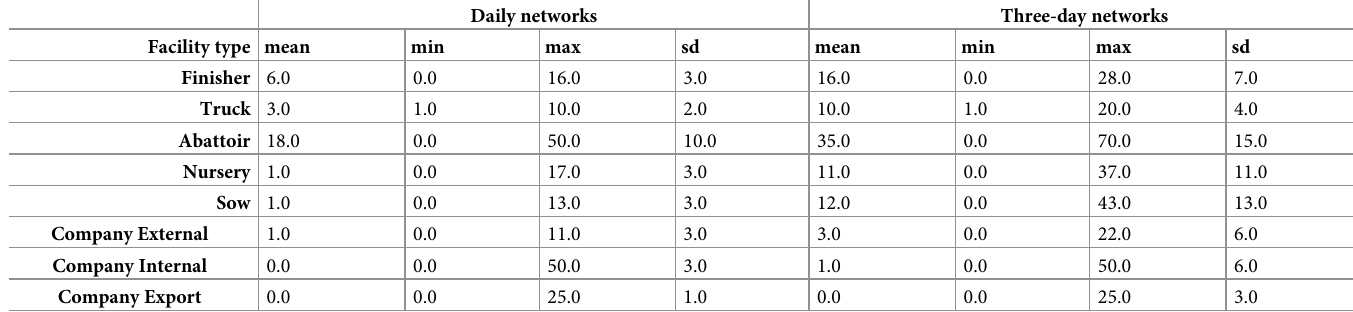
Table 3. Proportional representation of each facility type in the maximum weak component obtained from daily and 3-day 2-mode networks over the entire 2015, expressed as a descriptive statistic of the percent of each facility type in the study